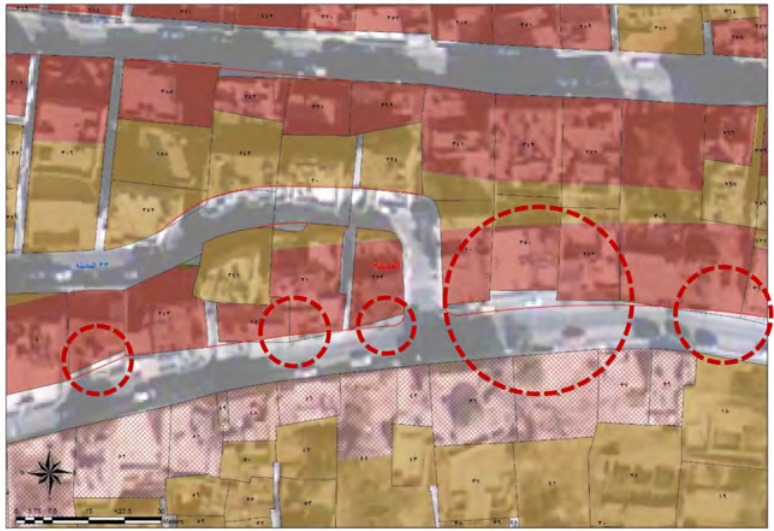
Figure 2. Land leftover land-use over aerial view map. Source: GAM- GIS for the author